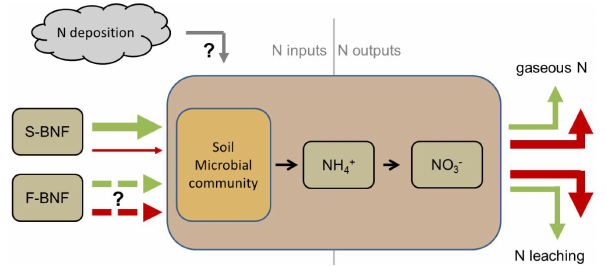
Figure 5. The leaky nitrostat model adapted from Hedin et al. (2009). This model indicates the importance of symbiotic (S- BNF) and free-living (F-BNF) biological N 2 fixation along a for- est successional gradient, from young (green) to mature (red) forest stands. At the initial stages of ecosystem succession, the N supply via S-BNF, F-BNF and N deposition supports high ecosystem N de- mands. In mature forest stands with a lower N demand, S-BNF is down-regulated, but N inputs via F-BNF and N deposition lead to ecosystem N losses via N leaching and gaseous N